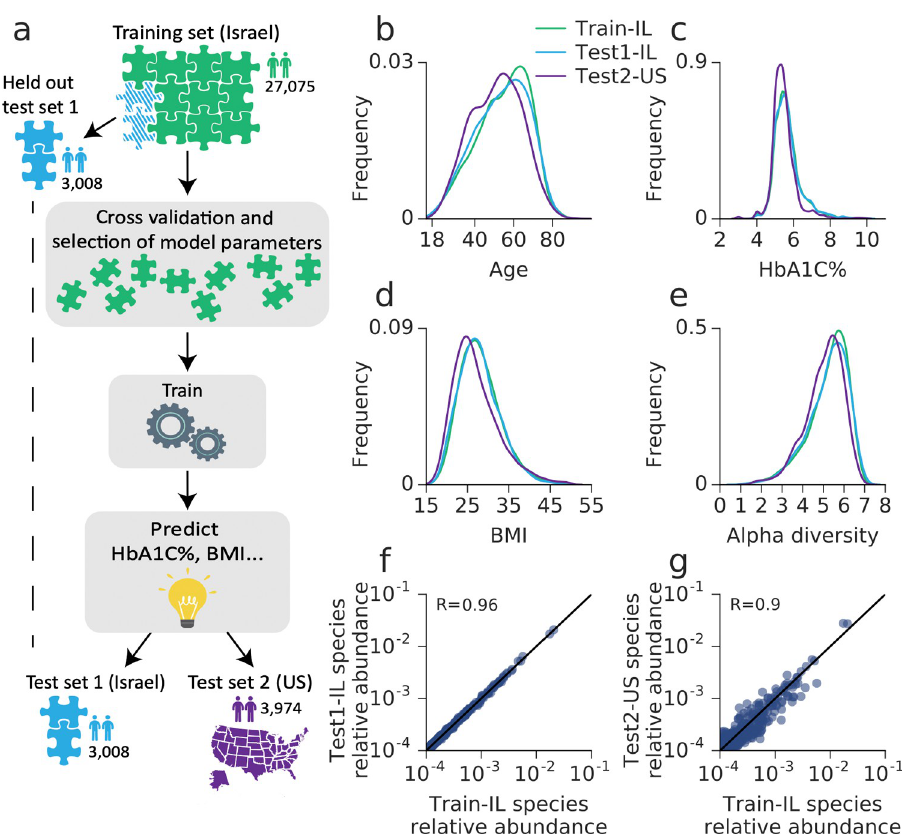
Fig 1. Cohort description and model prediction scheme. (a) Illustration of cohorts and machine learning process. A training set of 27,075 individuals was randomly selected out of 30,083 Israeli individuals and was used for model parameter selection using 10-fold cross validation and microbiome, age and gender features. For each phenotype the selected model was trained on the 27,075 training samples and then tested on both the held out 3,008 samples of the Israeli population and a separate U.S. test cohort of 3,974 individuals. (b) Distribution of age in the 3 cohorts, training test1 and test2. (c)-(e) Same for HbA1C%, BMI and alpha diversity. (f) A scatter plot comparing the mean log RA of each species, in the Israeli training cohort vs. the Israeli test1 cohort. R value represents Spearman correlation. (g) Same as (f) in the Israeli training cohort vs. the US test2 cohort. R value represents Spearman correlation.